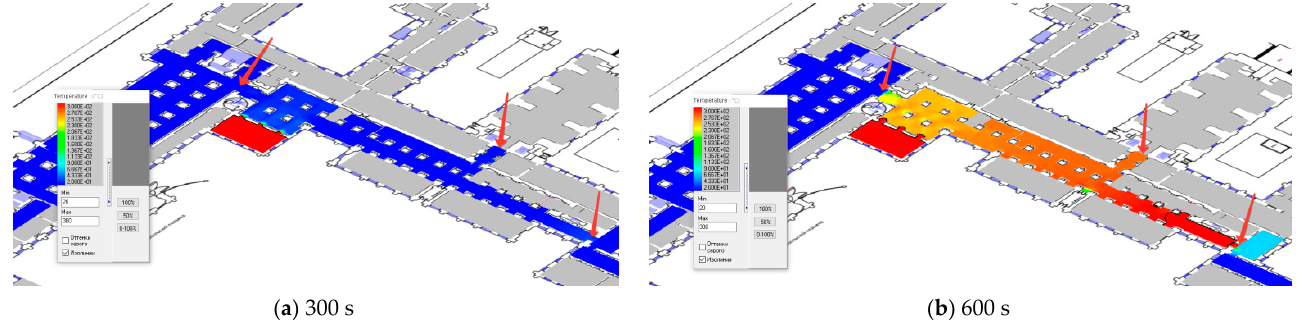
Figure 13. Horizontal slices of temperature (°C) at a height of 1.7 m from the floor in the scenario “The fire in the foyer of the Wooden Staircase”, the color changes from blue (20 °C) to red (300 °C). Similarly, the analysis of the results of calculations of other scenarios was carried out.